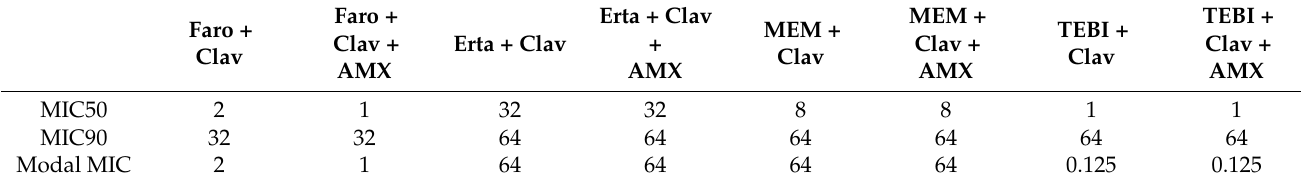
Table 2. MIC 50 , MIC 90 and modal MIC values of carbapenems in association with clavulanic acid alone as well as clavulanic acid and amoxicillin for fully susceptible MTB strains. Clavulanic acid was used at a fixed concentration of 2.5 mg/L, and amoxicillin was used at a fixed concentration of 2 mg/L. Faro, faropenem; Clav, clavulanic acid; AMX, amoxicillin; Erta, ertapenem; MEM, meropenem; TEBI,